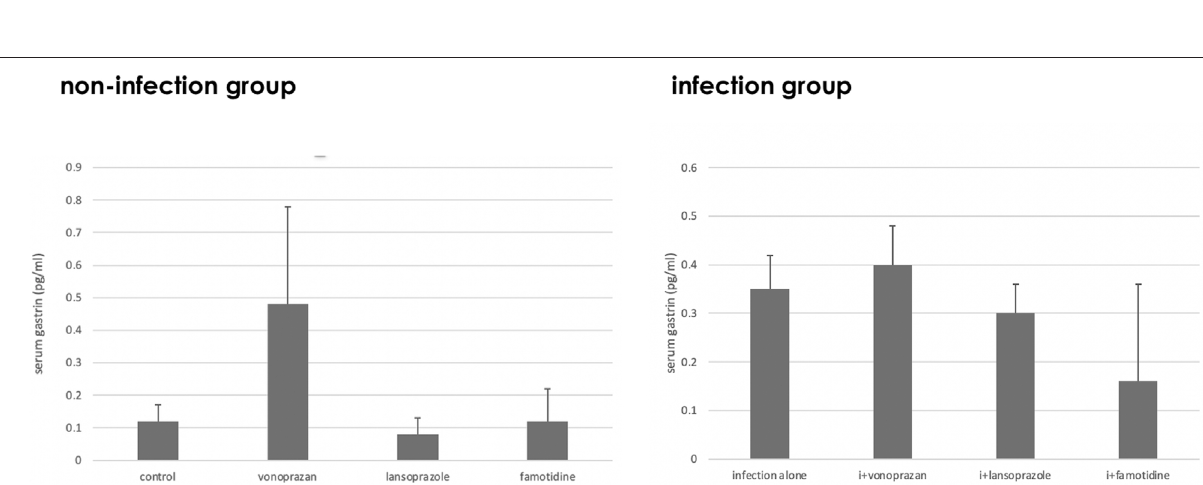
Frontiers in Pharmacology |